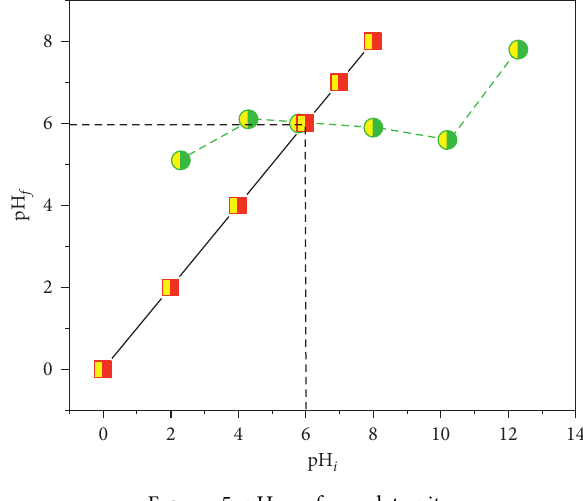
Figure 5: pH pzc of raw date